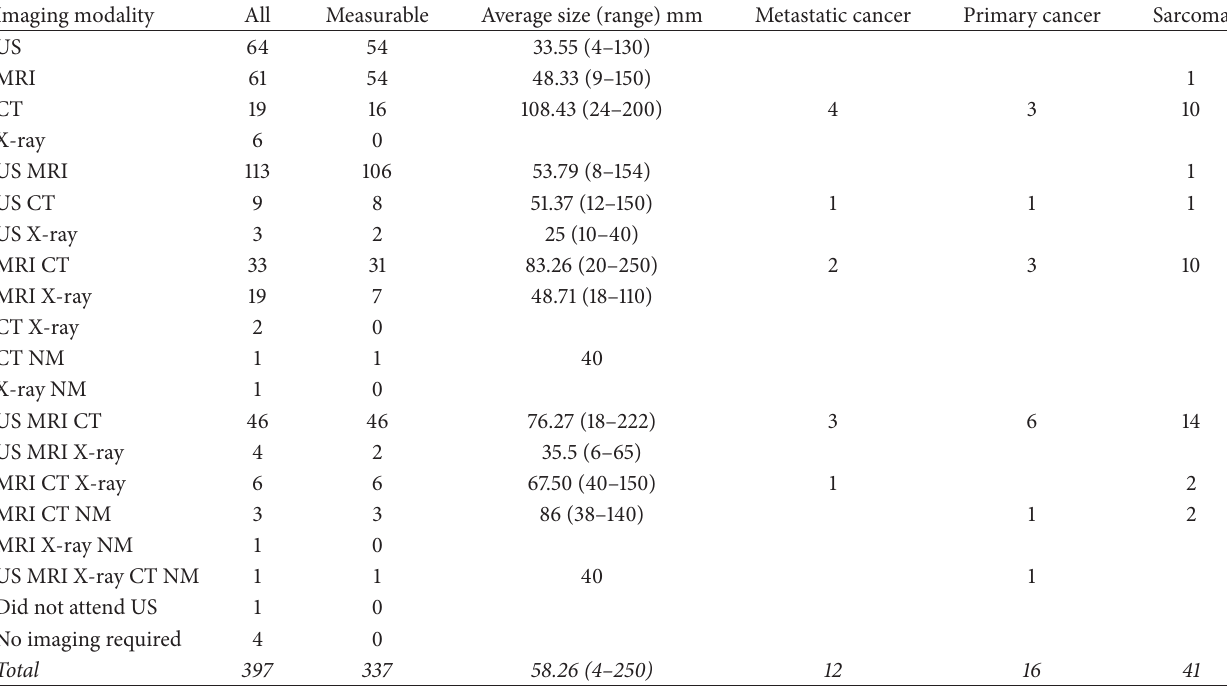
Table 2: Pattern of radiological investigations and malignancy detection